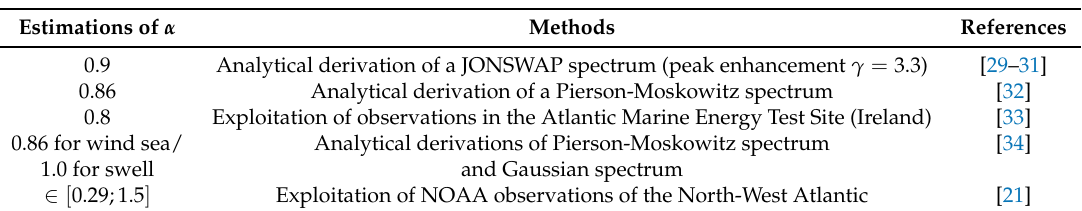
Table 2. Estimations of the calibration coefficient α between the peak period T p and the energy period T e ( T e = α T p